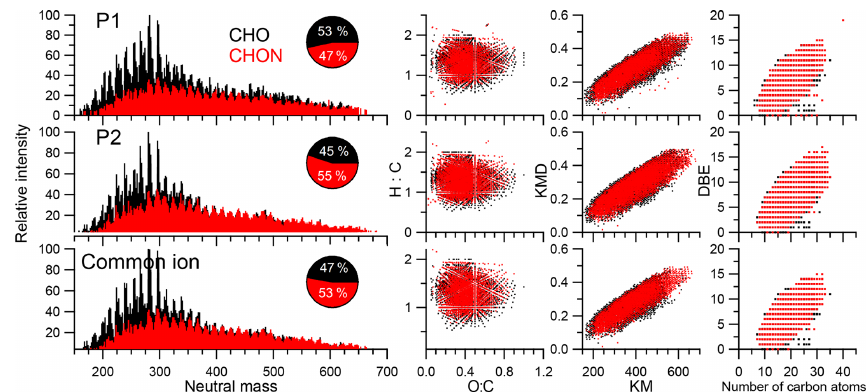
Figure 3. The combination plot for all molecular formulas of P1, P2, and common ions including the high-resolution mass spectrum, the Van Krevelen diagram, Kendrick mass defects (KMDs) vs. Kendrick mass (KM), and double bond equivalents (DBEs) vs. number of carbon